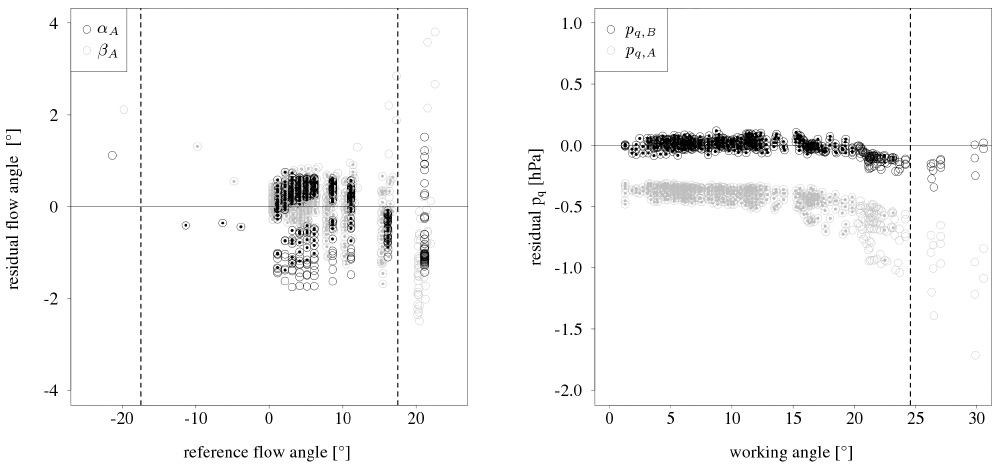
Fig. 7. Wind tunnel evaluation results: open circles represent the residuals for all combinations of flow angles ( α A , β A , left) and dynamic pressure before ( p q, A ) and after ( p q, B ) wind tunnel correction (right). Full circles indicate subsets that lie in the (extended) operational flow angle range of ± 17.5 ◦ . These subsets are used for the uncertainty assessment. Dashed vertical lines indicate the corresponding thresholds of flow angle and working angle (acos ( cos α cos β) ), respectively.